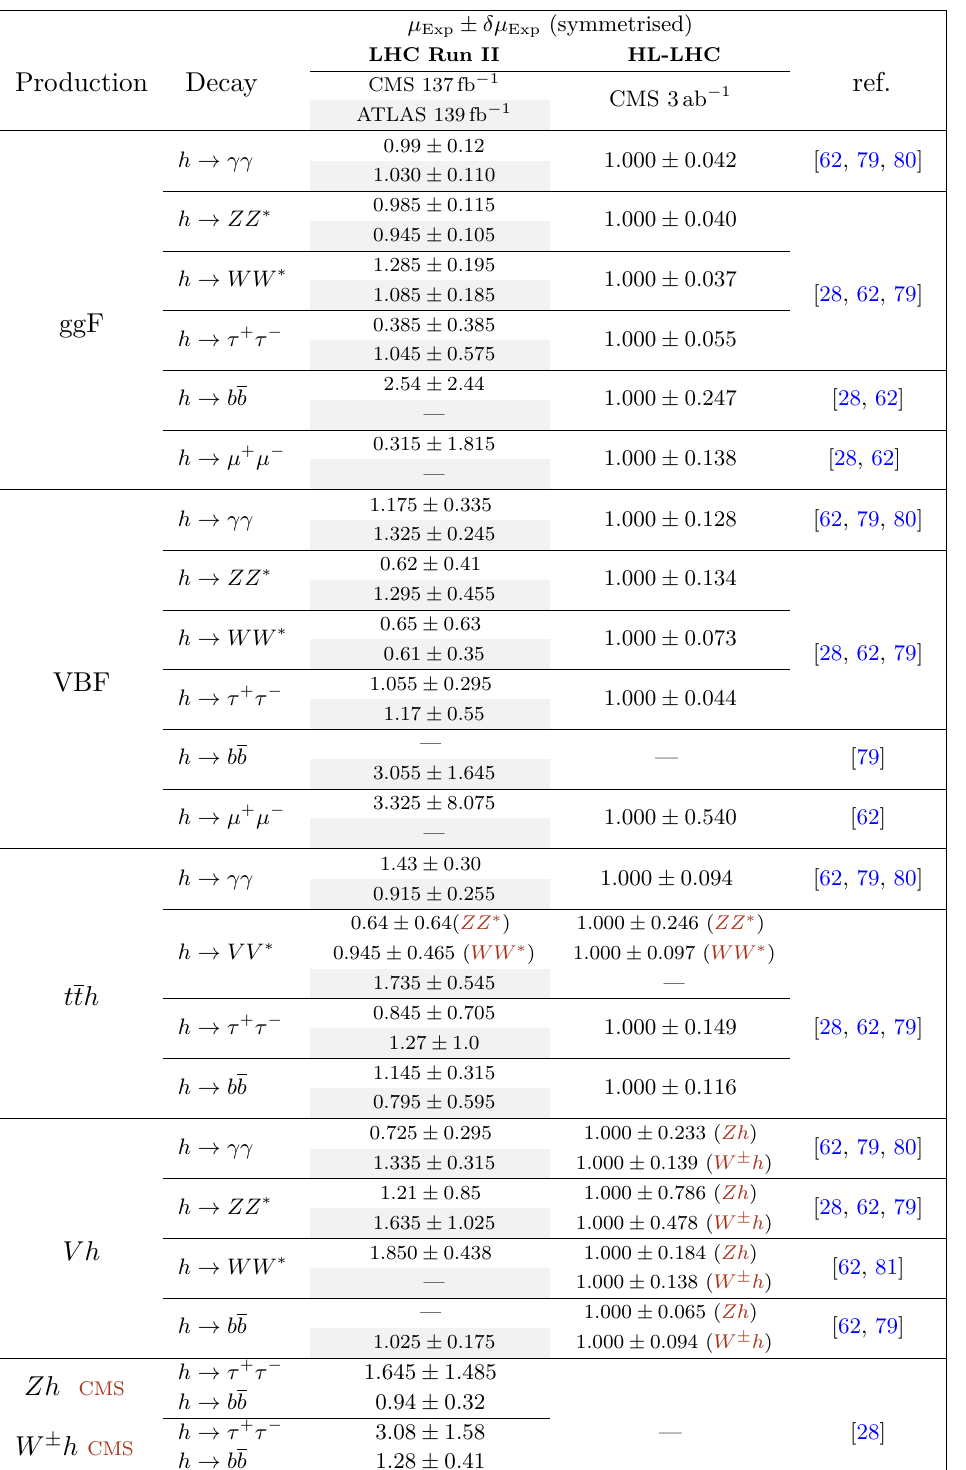
Table 3 . The experimental measurements of single-Higgs observables from the LHC Run II and projections for the HL-LHC. In all cases we have symmetrised the experimental uncertainties that we use in the